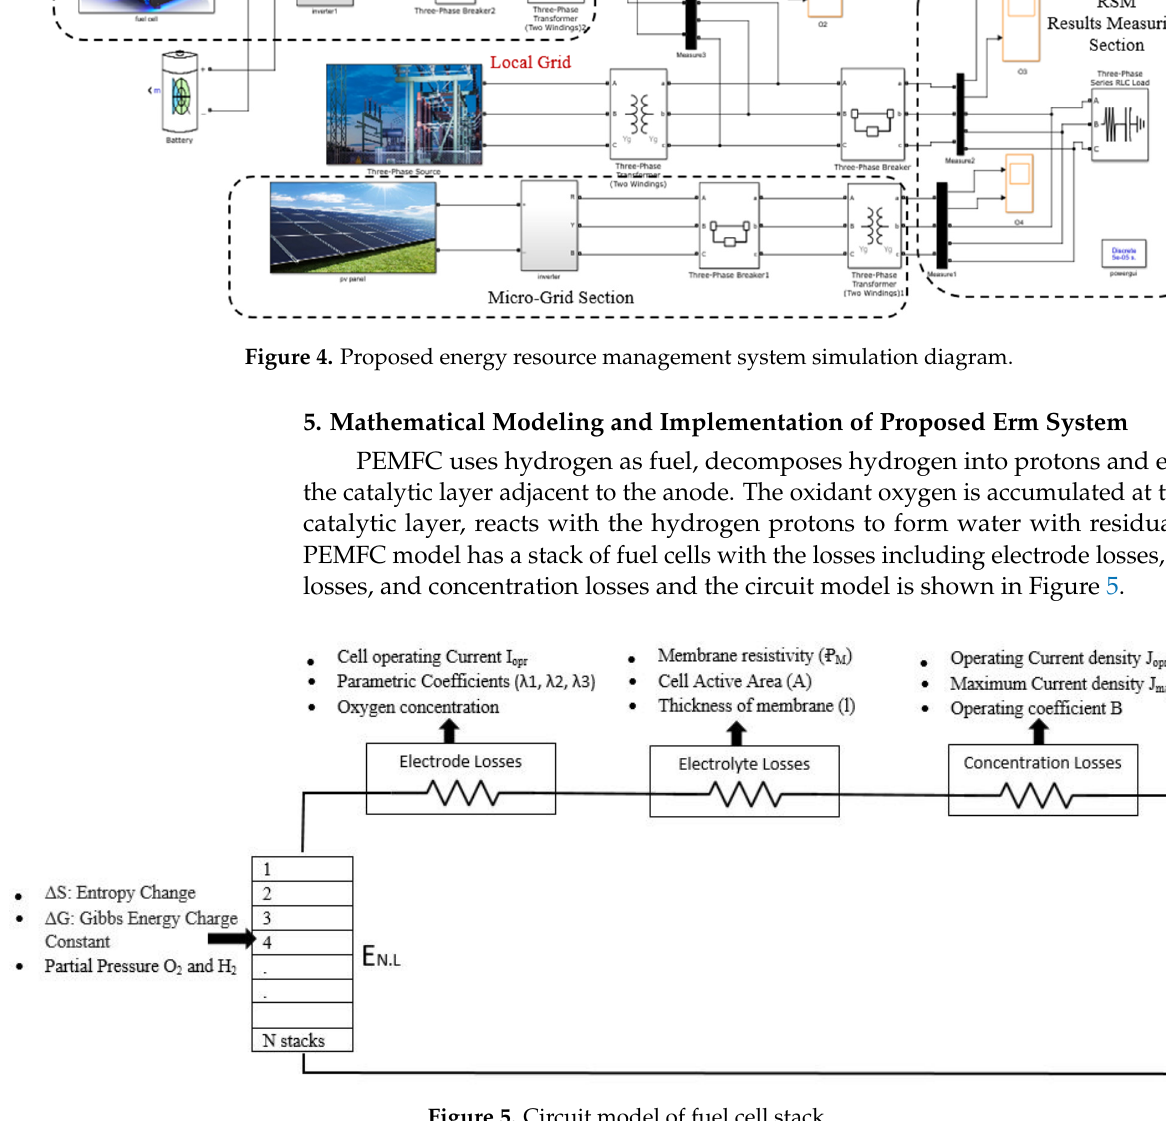
Figure 5. Circuit model of fuel cell stack.